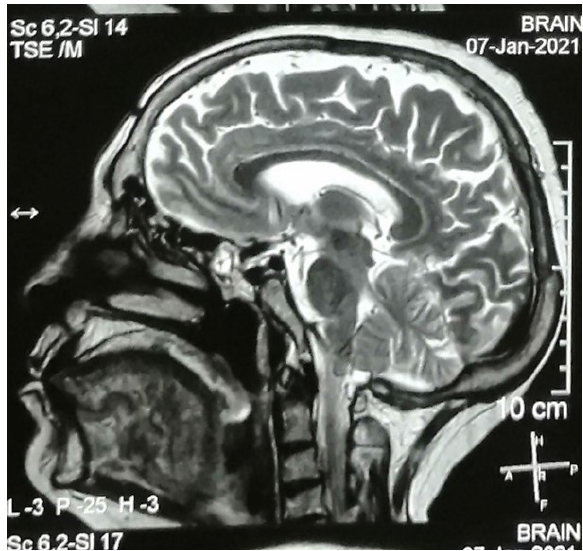
Figure 2 . MRI brain with sagittal T2-weighted image showing age related brain